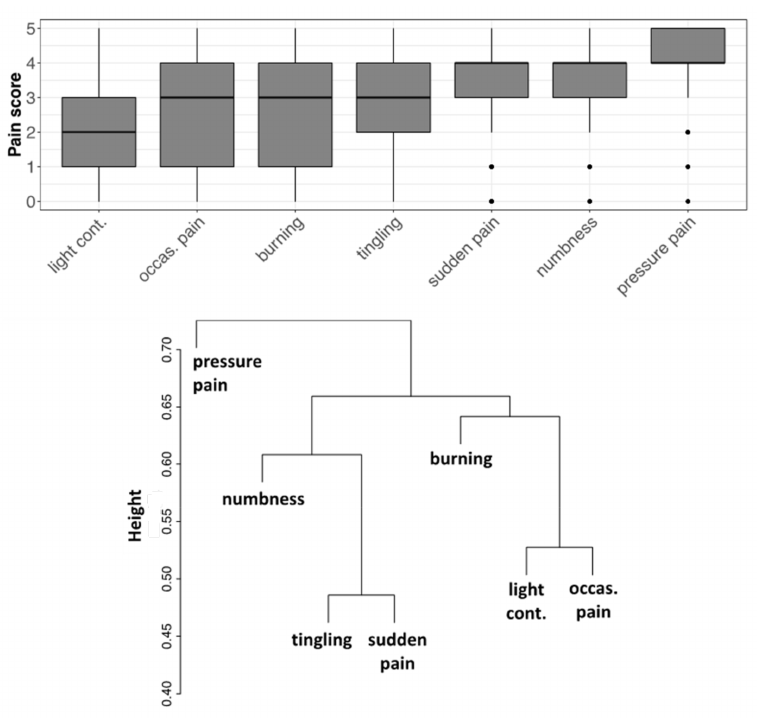
Figure 4. Scores reported by subjects for each pain type. ( Top ) Boxplots of score distributions for each type of pain experienced by patients in the last week before questionnaire compilation. ( Bottom ) Dendrogram of the different types of pain, generated using an average linkage agglomerative algorithm based on pairwise correlations between pain intensities. The distance used is one minus the correlation coefficient. The height of each node (vertical axis) is the distance value between the right and left sub-branch clusters. Light cont. = light contact; Occas. pain = occasional pain; Sample size n =